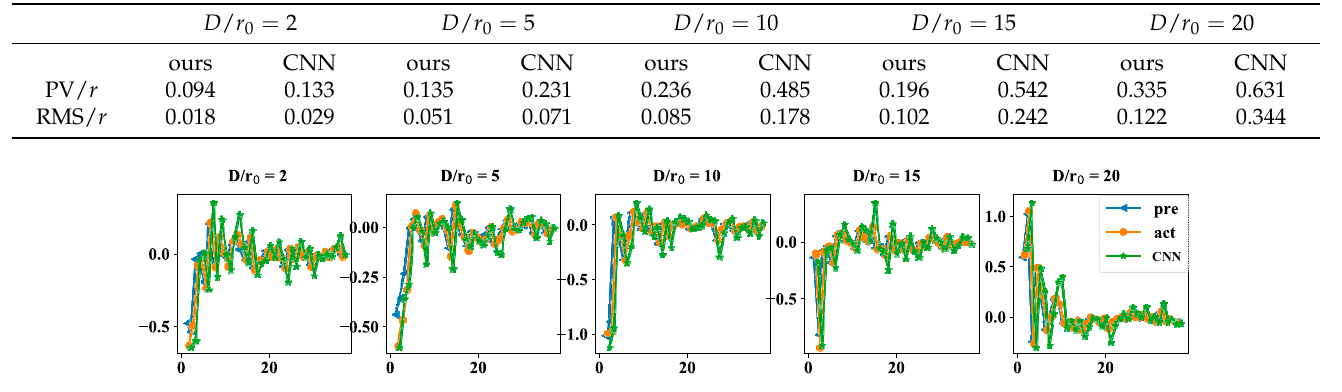
Figure 7. Predicted Zernike coefficient versus actual. Table 2. PV and RMS values of the residual phase at different turbulence intensities.